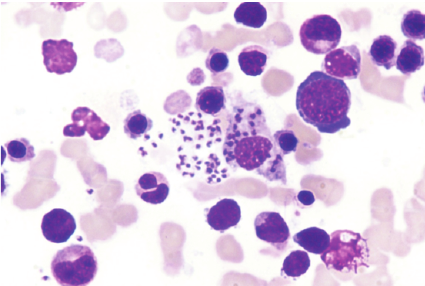
Figure 1: Photography of bone marrow smear showing massive bone marrow infiltration with amastigotes. Optical microscopy, Wright Giemsa stain, 100x